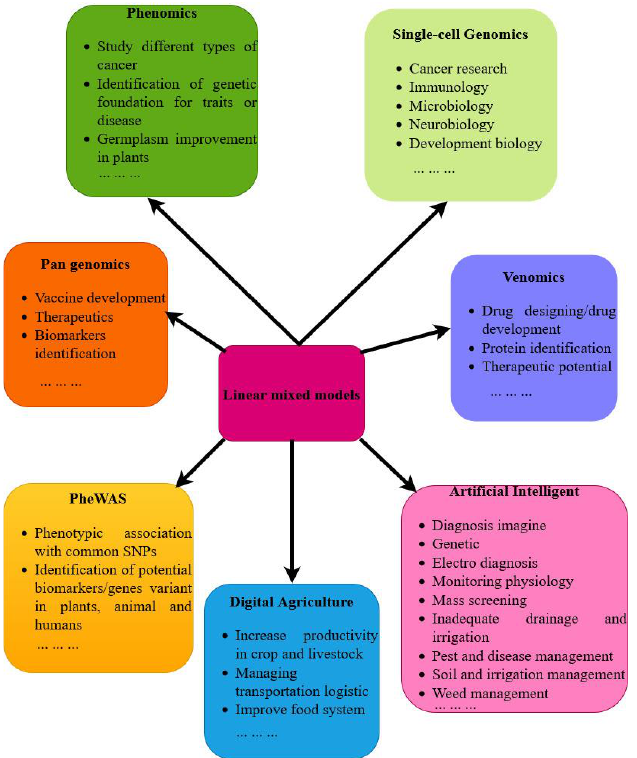
Figure 4. Linear mixed models (LMMs) could be used in the above potential fields currently devel-